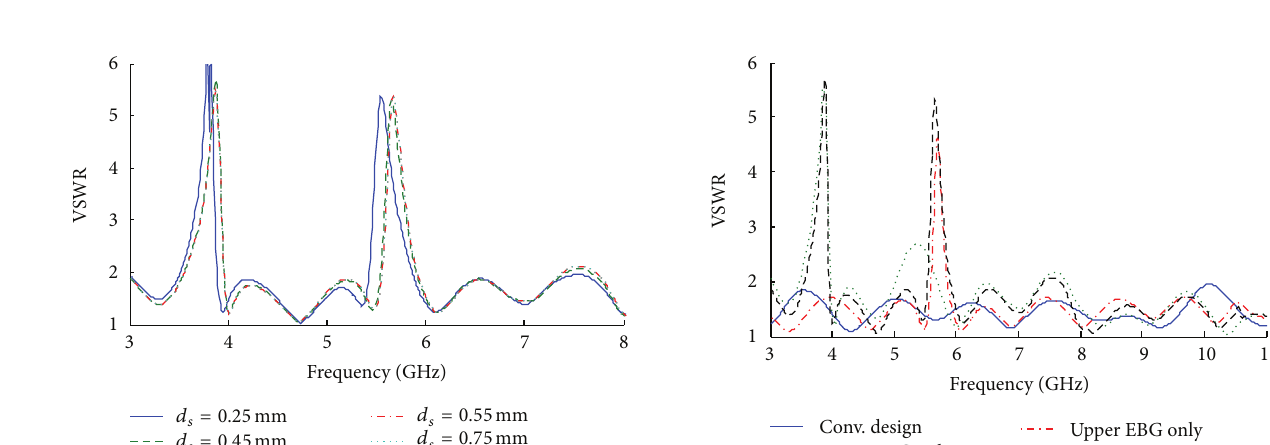
the lower EBG pair results in a VSWR < 2 over the UWB range except for the 3.6–3.9 GHz band (VSWR = 5.8). Similarly, the upper EBG pair produces an UWB response except for the 5.6–5.8 GHz band, which possesses a VSWR of 5.4. Finally, concatenating the two EBG pairs generates two simultaneous notches at the 3.6–3.9 and 5.6–5.8 GHz frequencies with VSWR values of 5.8 and 5.4, respectively,